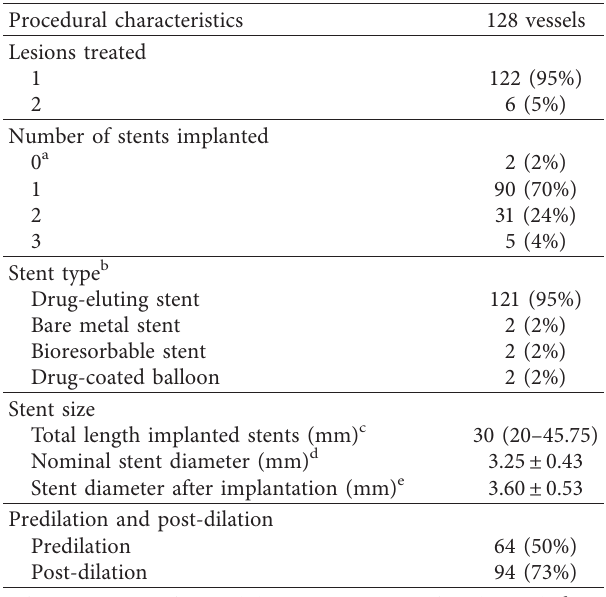
Table 3: Procedural characteristics.